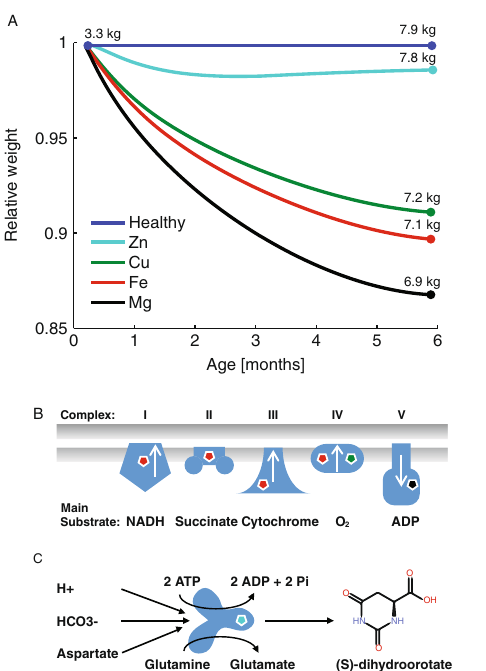
Fig. 4 The metabolic effects of co factor de fi ciency was simulated by decreasing the fl uxes through the reactions that depend on the cofactors to 95% optimal value. a The relative weight of infants with different cofactor de fi ciencies compared to healthy infants. b The strong decrease in growth for Fe, Cu, and Mg de fi ciency was caused by limitations in the energy generation, Fe and Cu are required for a functional electron transport chain 67 and Mg is used by the ATP forming Complex V, 68 i.e. ATP synthase. c The Zn de fi ciency affected the CAD protein (carbamoyl-phosphate synthetase 2, aspartate transcarbamoylase and dihydroorotase), limiting the synthesis of the nucleotide precursor (S)-dihydroorotic